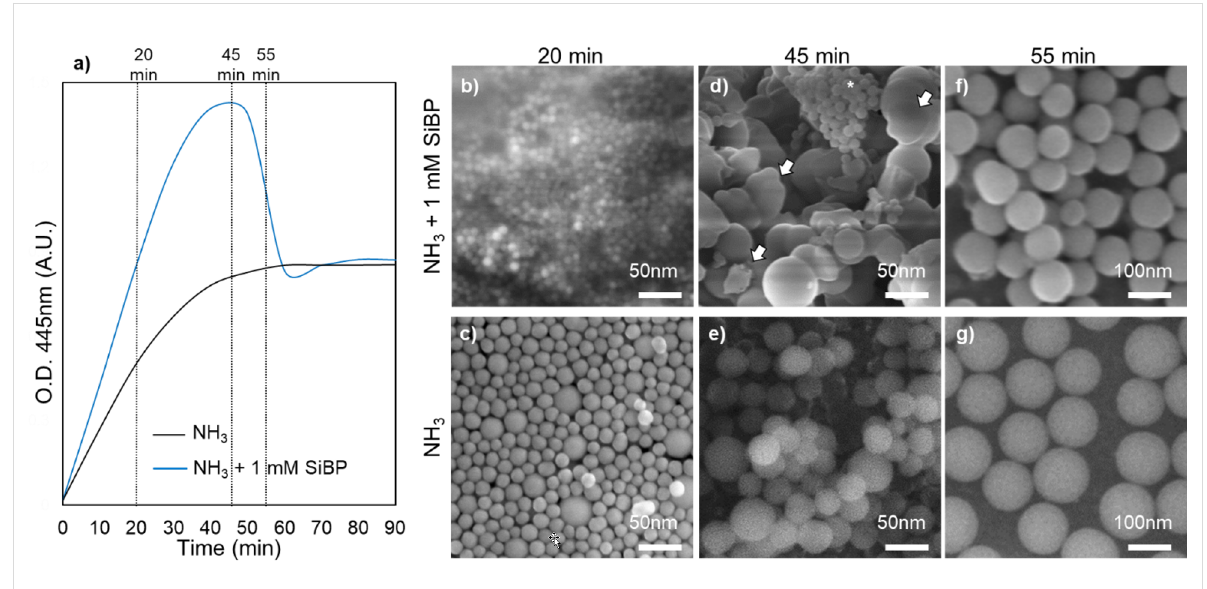
Figure 4: (a) UV–vis spectra of the reactions with NH 3 alone and NH 3 + 1 mM SiBP. SEM images of the SiO 2 particles collected after (b, c) 20 min, (d, e) 45 min, and (f, g) 55 min (arrows: coalescing particles, asterisk: clusters of approx. 10 nm particles).